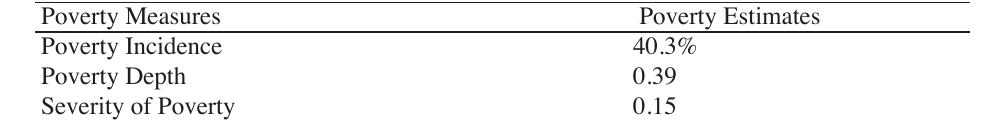
Poverty Estimates of Households in Athara Hazari Sub District. Poverty Measures